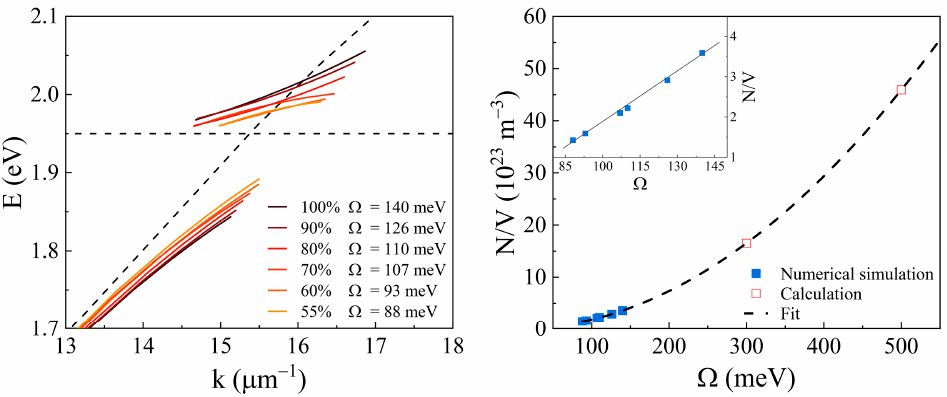
Figure 5. Calculations of SPP–exciton wave vector dispersion in the strong coupling regime for dif ‐ ferent concentrations (55–100%) of protein–dye complex ( left ) and adsorbed protein molecule con ‐ centration dependence on modeled Rabi energy gap ( right ). The black dashed lines on the left indi ‐ cate the dispersions of single SPP and exciton. The blue squares on the right indicate the numerically simulated, while the red squares are calculated Ω values.